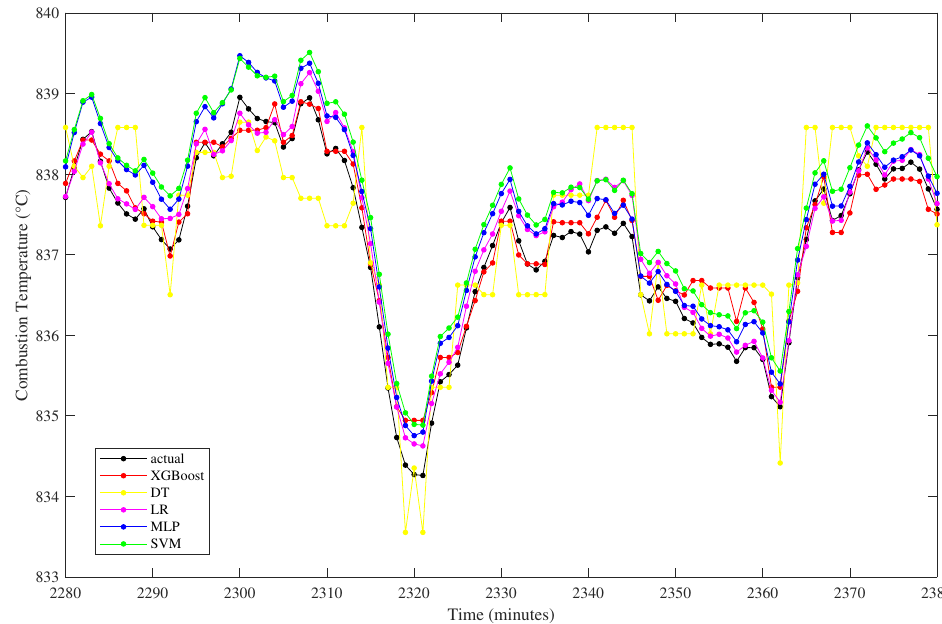
Figure 9. Combustion Temperature prediction from different